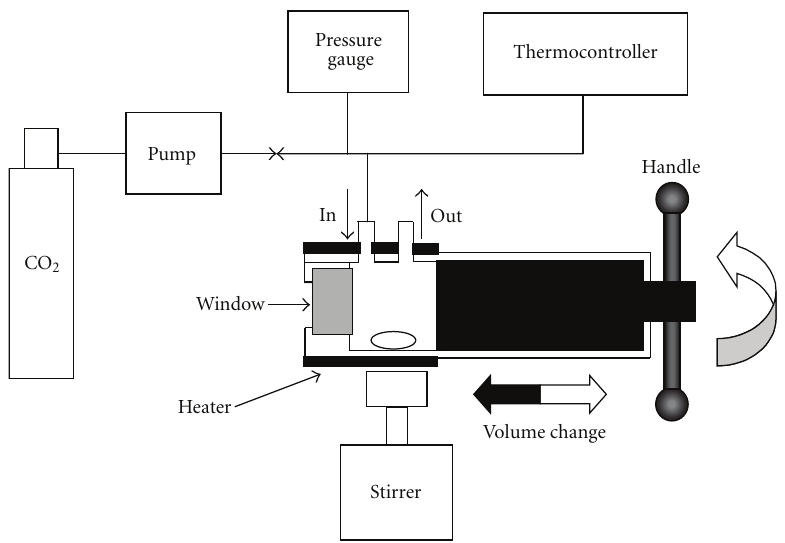
Scheme 2: A schematic of the experimental variable volume view cell.